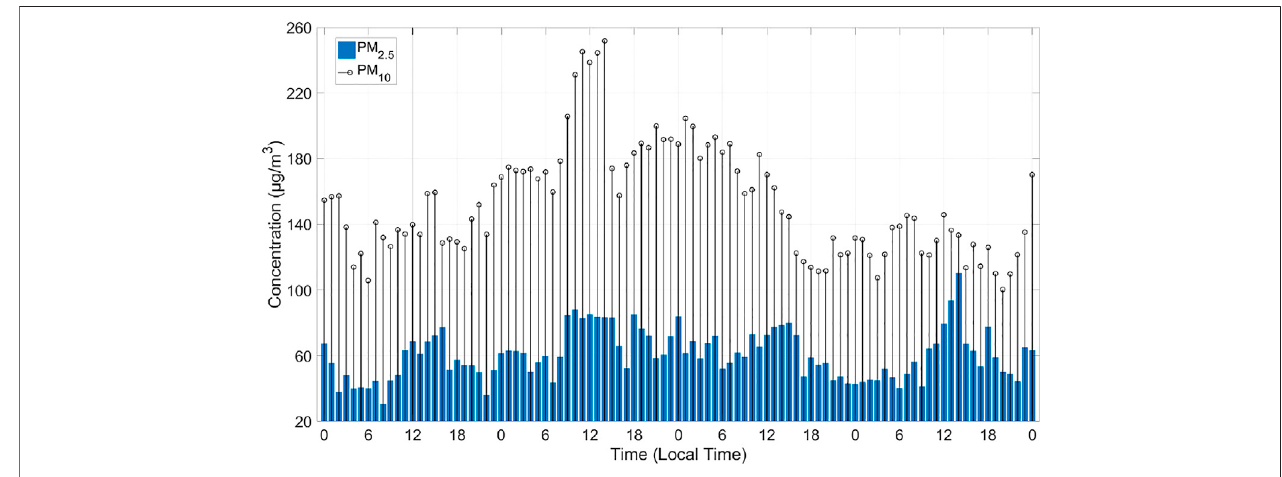
FIGURE 11 | Air quality monitoring data.